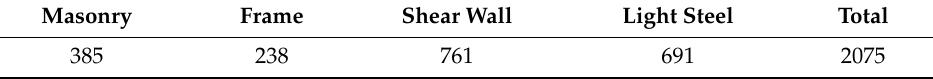
Table 3. Structure types and numbers of investigated buildings.